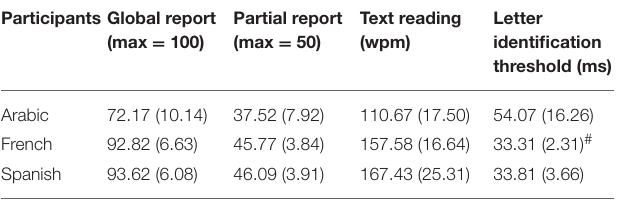
TABLE 1 | Performance (mean and SD) of the Arabic, French, and Spanish participants in global and partial report, text reading and single letter